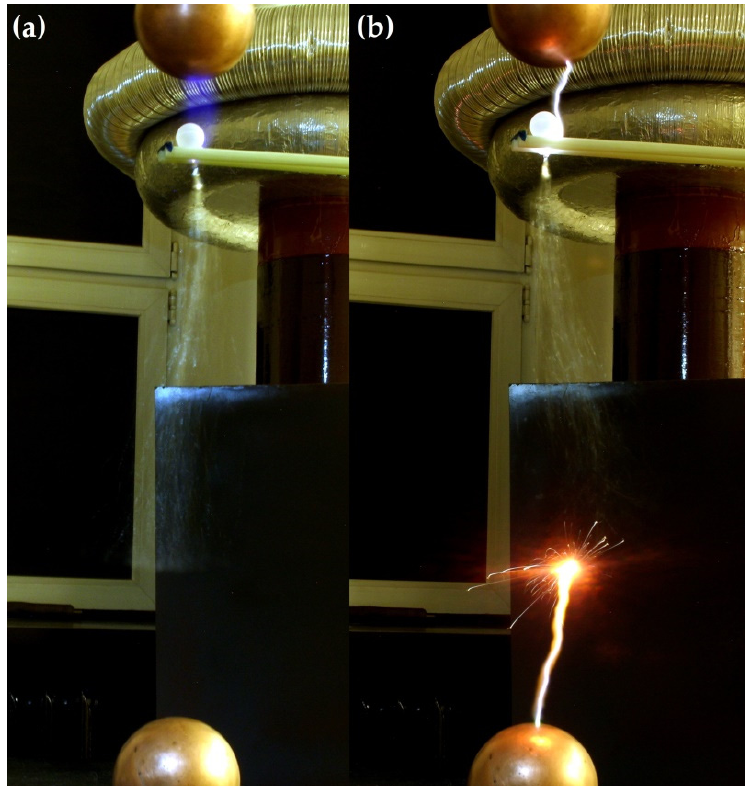
Figure 10 . A simulated lightning strike in the axial positions of the electrodes around the flight train model (polarization negative; 8 s exposure): image ( a ) presents the corona appearing shortly before the flashover; ( b ) the flashover with destructive impact on the lower end of the antenna.